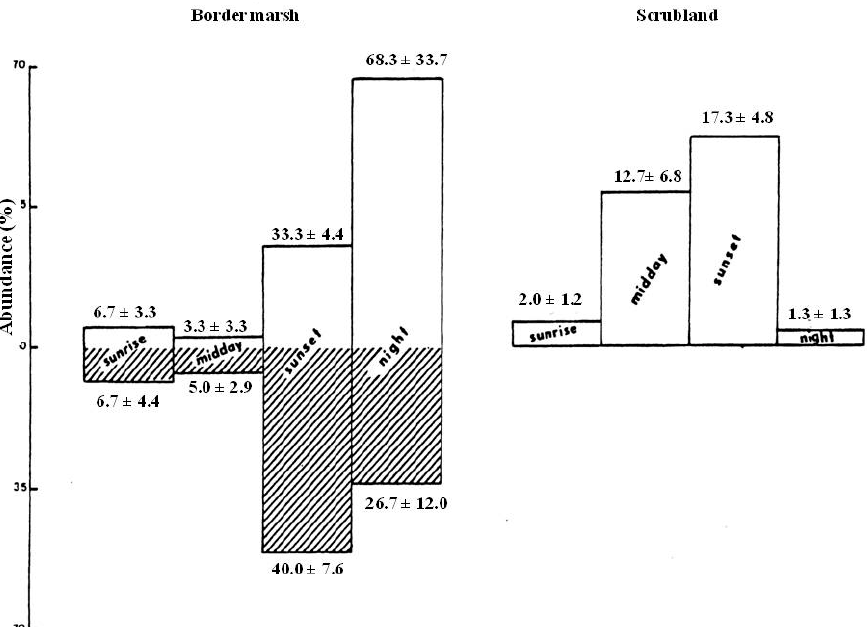
Figure 4. Circadian activity of European rabbits (white bars) and Iberian hares (stripped bars) at the border marshland and scrubland zones, estimated based on roadside counts in four time intervals over three consecutive days in winter 1985. Means ± SE of individuals/10 km are provided, and pairwise comparisons by species within a time period were not significant. For hares, observed changes included both habitat use and activity patterns. In the first study period (1984–1985), no hares were observed in the scrublands, and their activity peaked in the border marshlands at sunset (Figure 4). From 2005 to 2006, hares tended toward a nocturnal activity (Figure 5), not only in marshlands (although differences there were not significant, t = 0.14, p = 0.69), but also in the scrublands, where they had been absent during the roadside counts in 1984–1985.